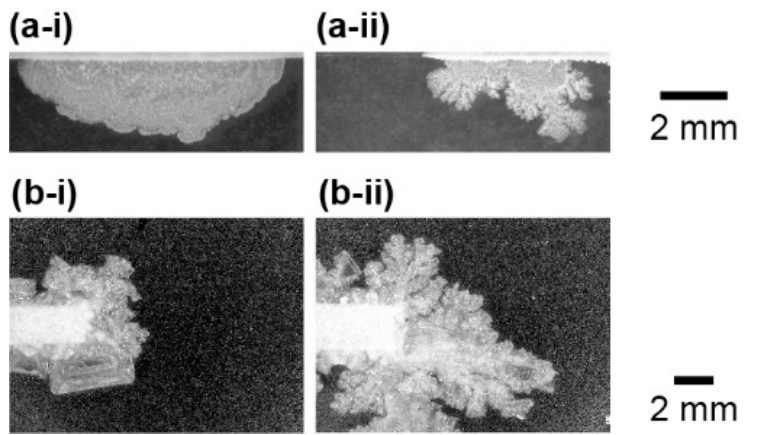
Figure 4. Shape of NaCl crystals formed on a glass surface. ( a ) Flat source system and ( b ) point source system. The concentrations of NaCl in the source solution were ( a-i ) 2.5 M, ( a-ii ) 5.0 M, ( b-i ) 3.0 M, and ( b-ii ) 5.0 M.